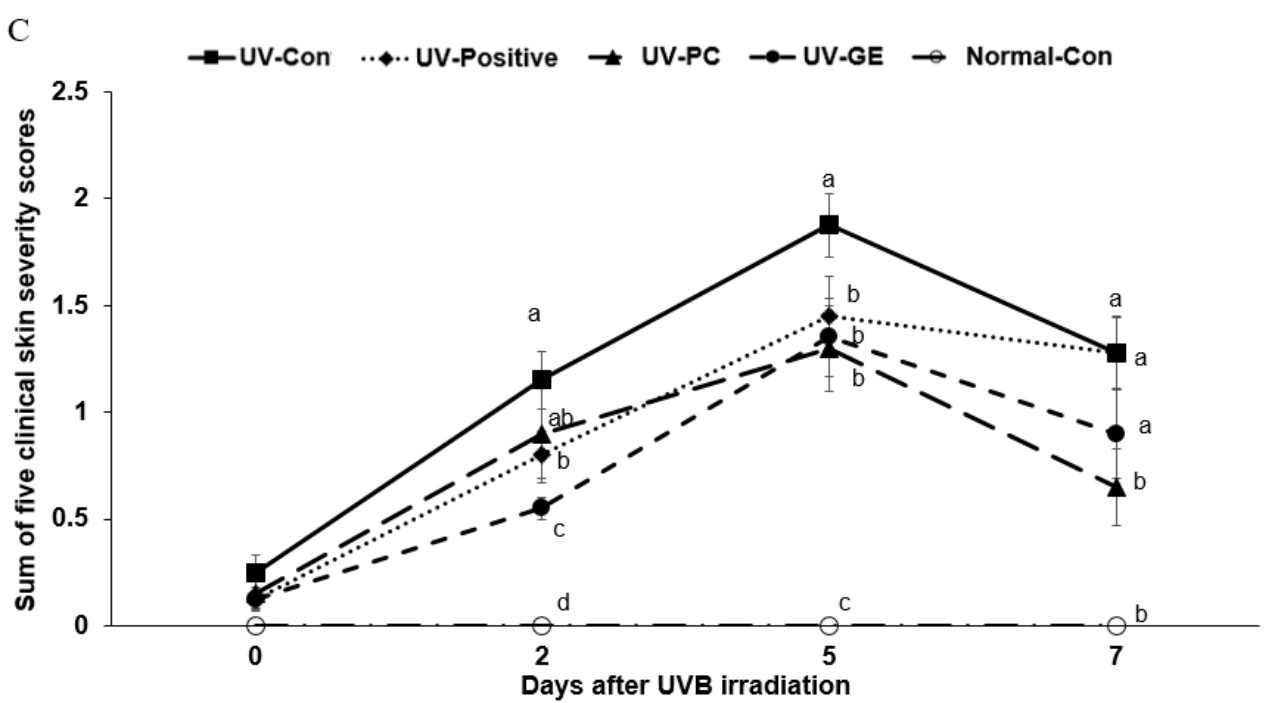
Figure 1. The severity of clinical photoaging symptoms. ( A ) Changes in photoaging symptoms at the dorsal skin lesion from day 14 to day 21. ( B ) The severity of each clinical photoaging symptom on the 21st day. ( C ) Average scores of clinical symptoms by identifying photoaging from day 0 to 7 days. a,b,c,d Means with different superscripts were significantly different among the groups in each parameter by the Tukey test at p < 0.05.